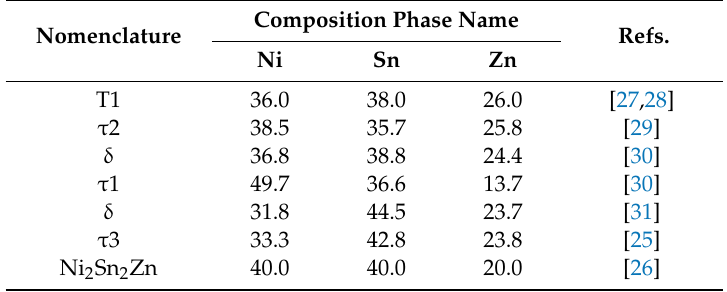
Table 1. Ternary phases contained about 20 at.% Zn and 40 at.% Sn found in the system Ni-Sn-Zn [25–31].